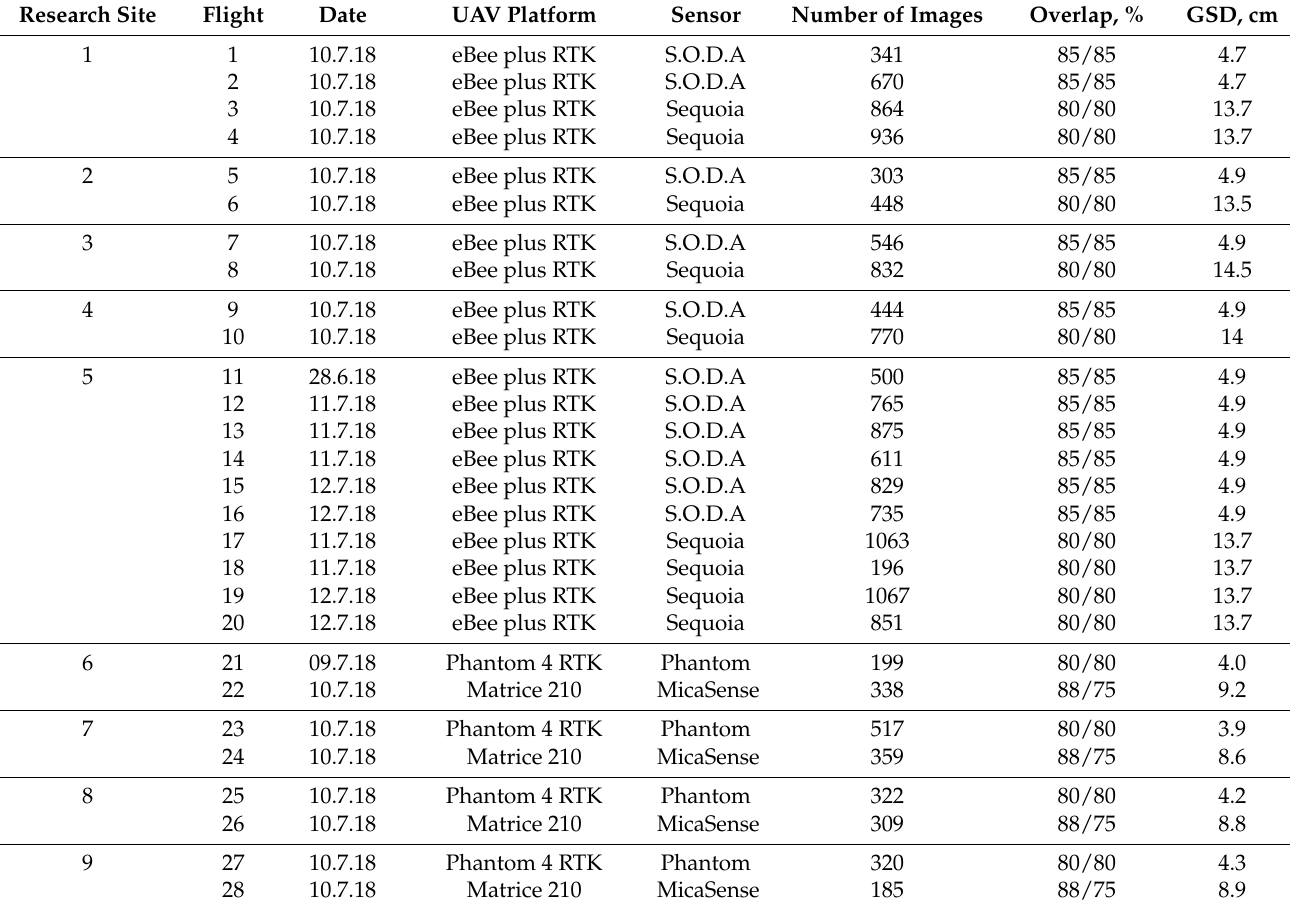
Table A1. Summary of flight characteristics for each research